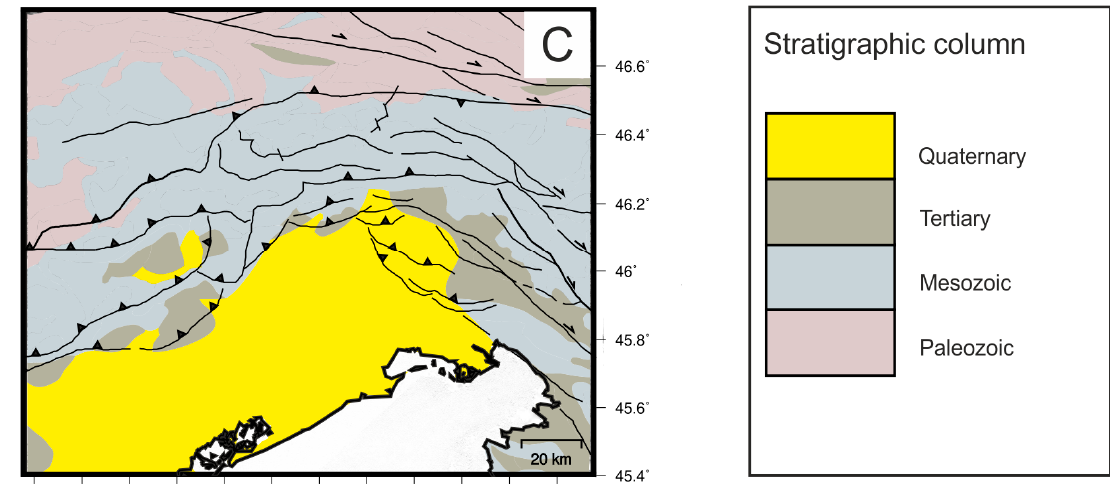
Figure 1. Seismotectonic map of the study area. ( A ) The map shows the seismicity and tectonics of the region. The blue-purple circles represent the instrumental seismicity for the 2000–2017 time span, provided by OGS bulletins (URL: http://www.crs.inogs.it/bollettino/RSFVG (accessed on 31 August 2020)) with focal mechanisms of the most important historical events [15,48,49]. ( B ) The map shows the tectonics and paleogeography of the area. (AR: Arba-Ragogna thrust; BL: Belluno thrust; BV: Bassano-Valdobbiadene thrust; CA: Cansiglio thrust; FS: Fella-Sava line; ID: Idrija fault; MD: Medea thrust; MT: Montello thrust; PAF: Periadriatic fault; PM: Polcenigo-Maniago thrust; PR: Predjama fault; PT: Pozzuolo thrust; RA: Raša fault; RV: Ravne Fault; ST: Susans-Tricesimo thrust; TBC: Thiene-Bassano-Cornuda thrusts; VS: Valsugana thrust). ( C ) Simplified geological map with stratigraphic column (Modified from: [67]).